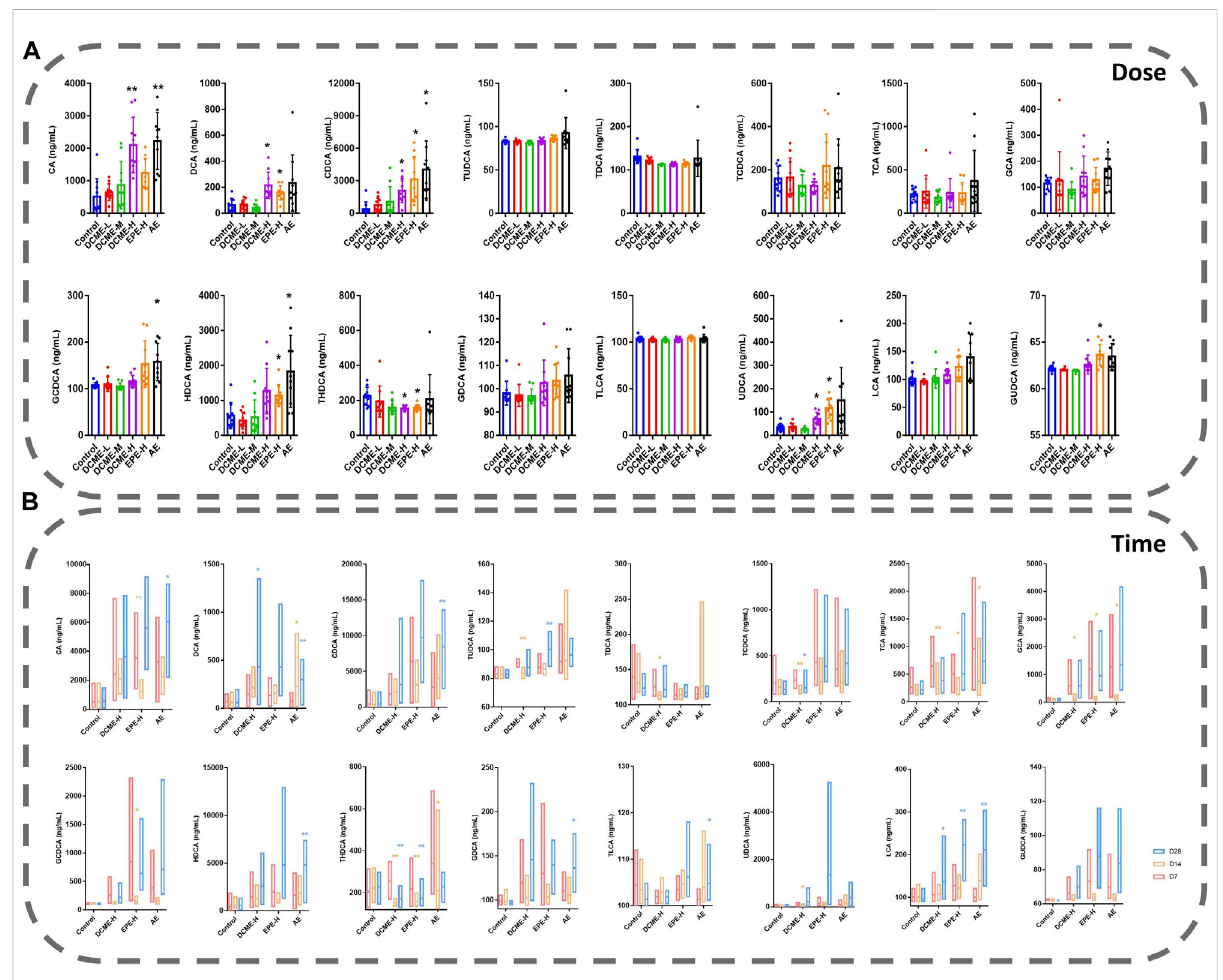
FIGURE 4 BileacidsinratserumsaftermultipleadministrationofdifferentdosesandtimesofSTRERextracts(n=10,mean±SD). (A) Experimentalgroups with different doses were contrasted with control groups. (B) Comparison between different time points for each group. * p < 0.05; ** p <